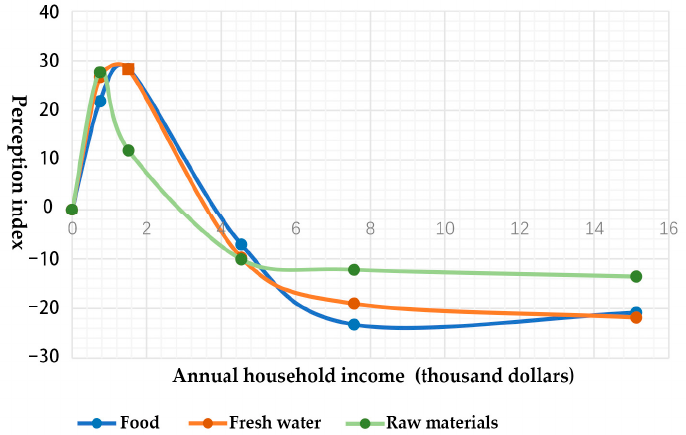
Figure A1. Correlation between perception of provisioning service and household income change.